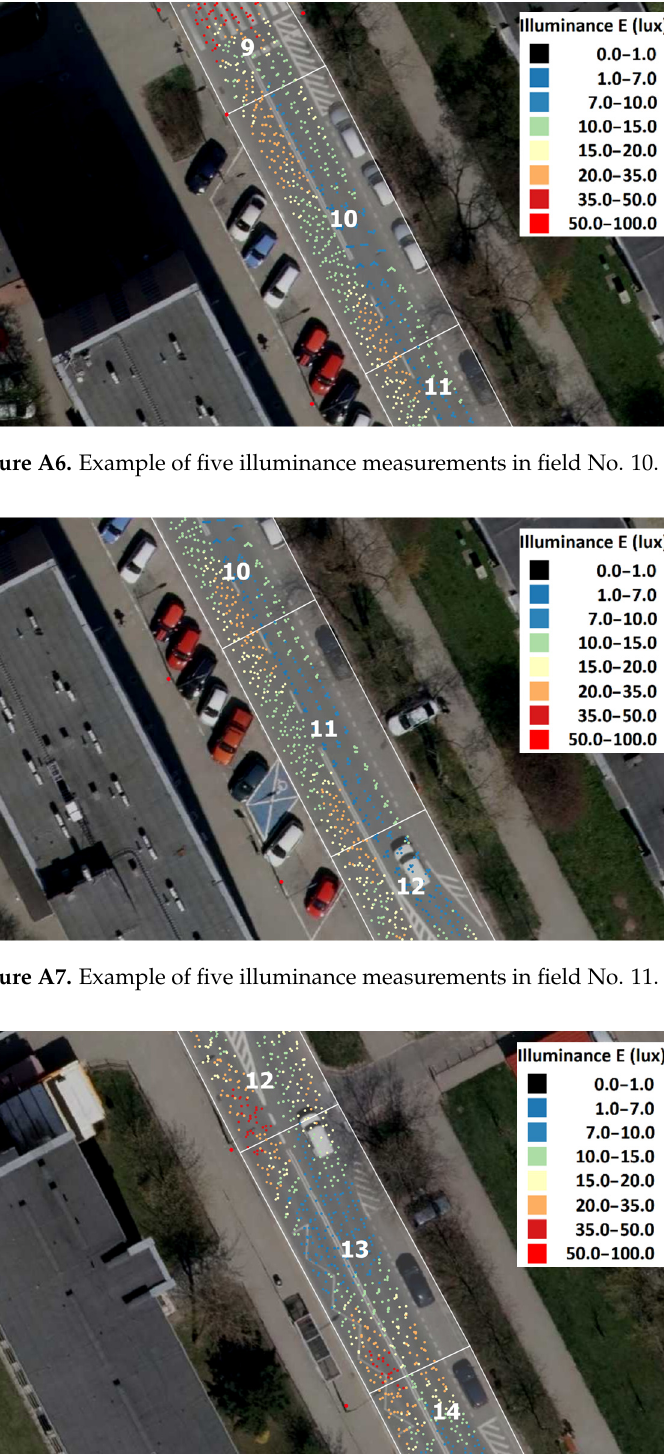
Figure A5. Example of five illuminance measurements in field No. 7.